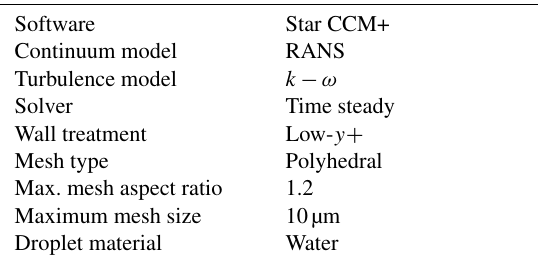
Table 2. Parameters used for the CFD-LPT